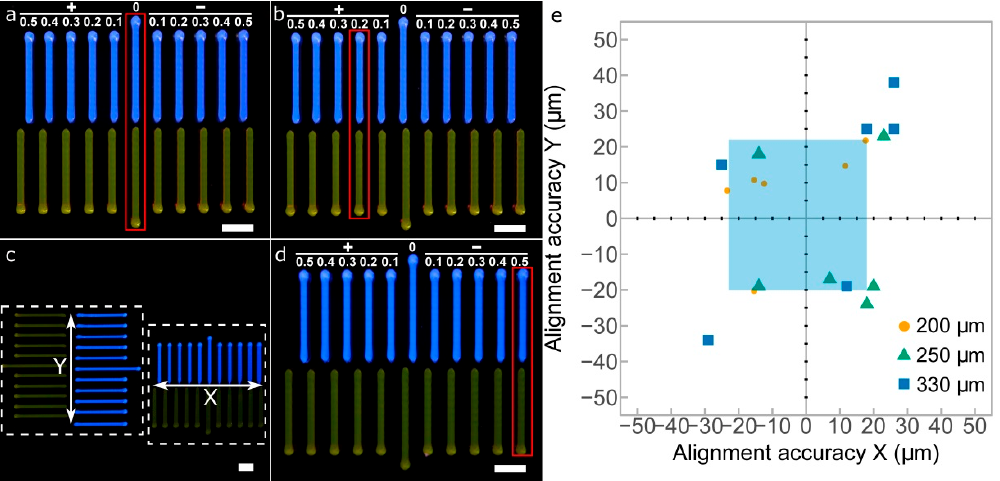
Figure 7. Images of the printed xy -offset pattern calibration model between P1 and P2. ( a ) perfect alignment between P1 and P2; ( b ) +200 μ m x -offset of P2 respect P1; ( c ) overall picture of x and y calibration models printed at the same time; ( d ) − 500 μ m x -offset of P2 respect P1; ( e ) alignment accuracy in x and y axes measured for three different nozzle sizes (200 μ m, 250 μ m, and 330 μ m); scale bars: 2 mm.